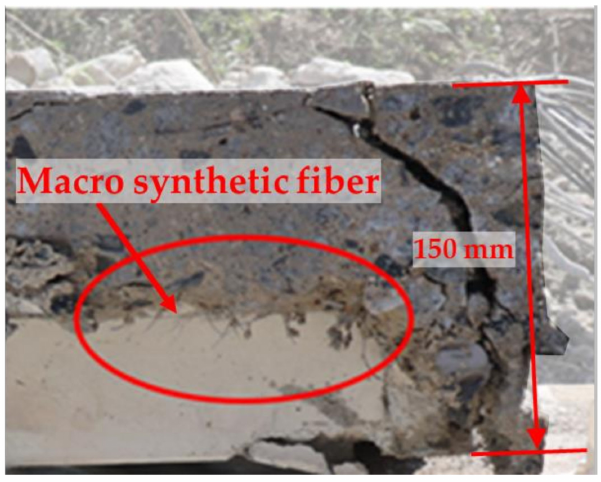
Figure 8. Section of